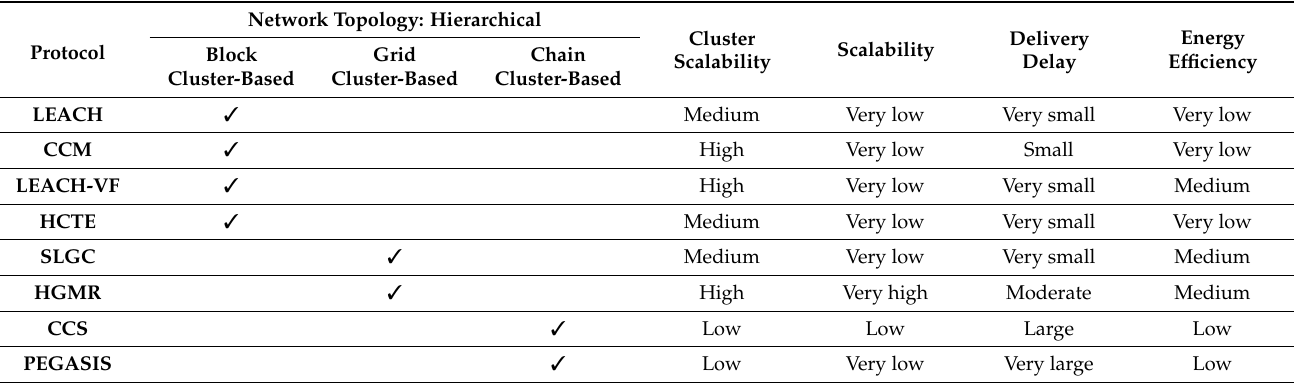
Table 5 establishes a comparison between hierarchical-based routing protocols [71]. Table 5. Routing protocols for